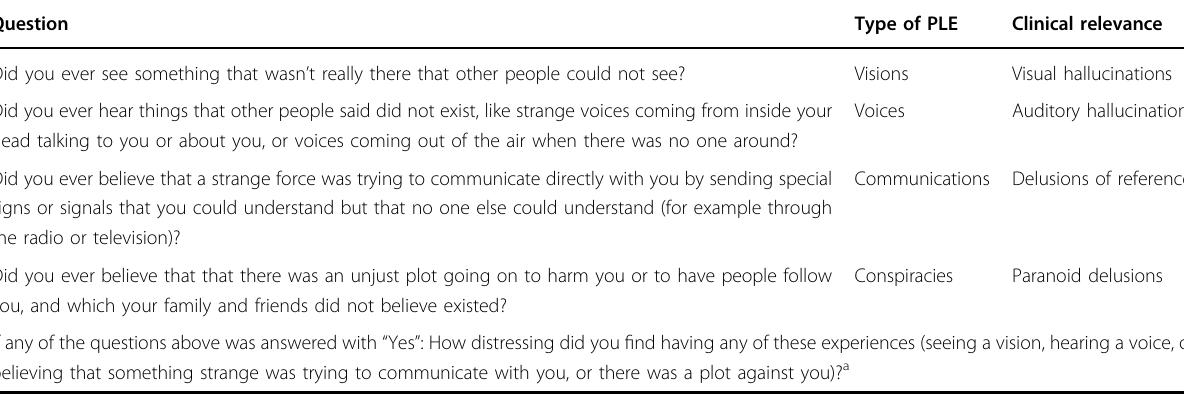
Table 1 Questions from UK Biobank Mental Health Questionnaire about psychotic experiences.